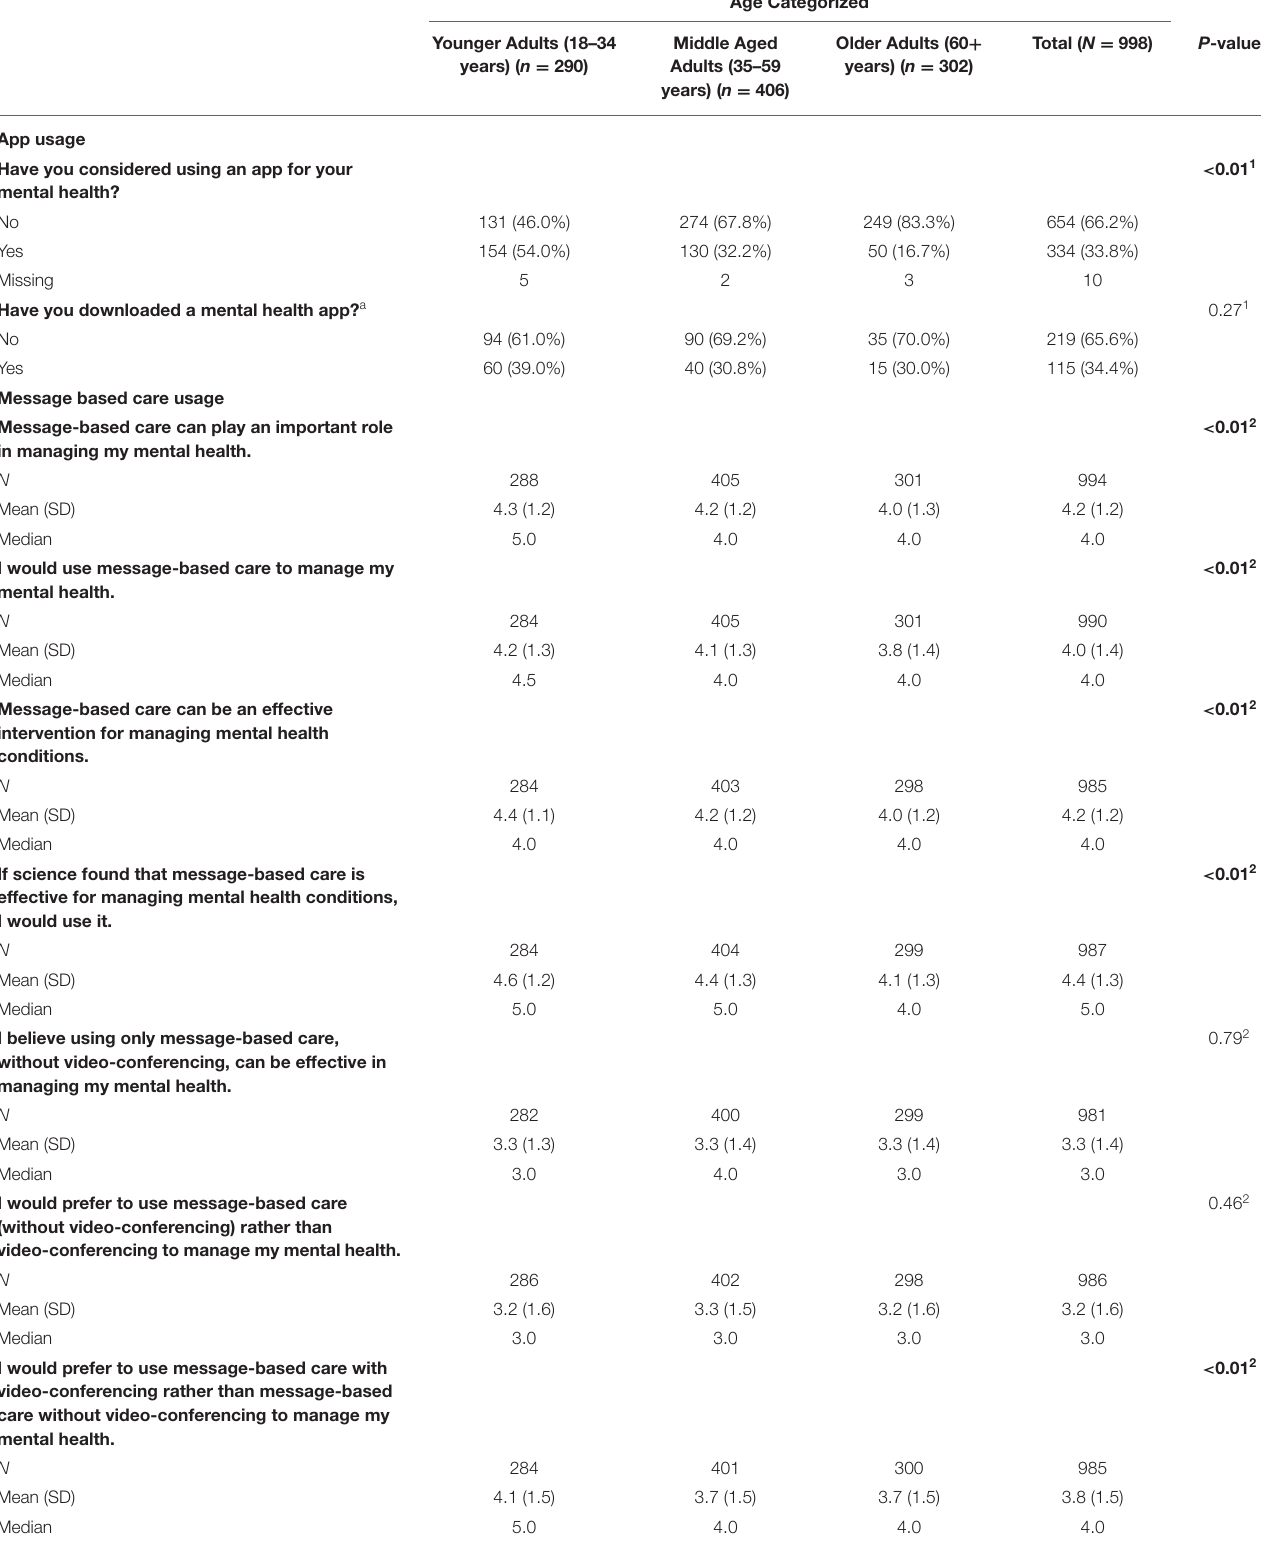
TABLE 2 | App, message based care, and telehealth usage stratified by age